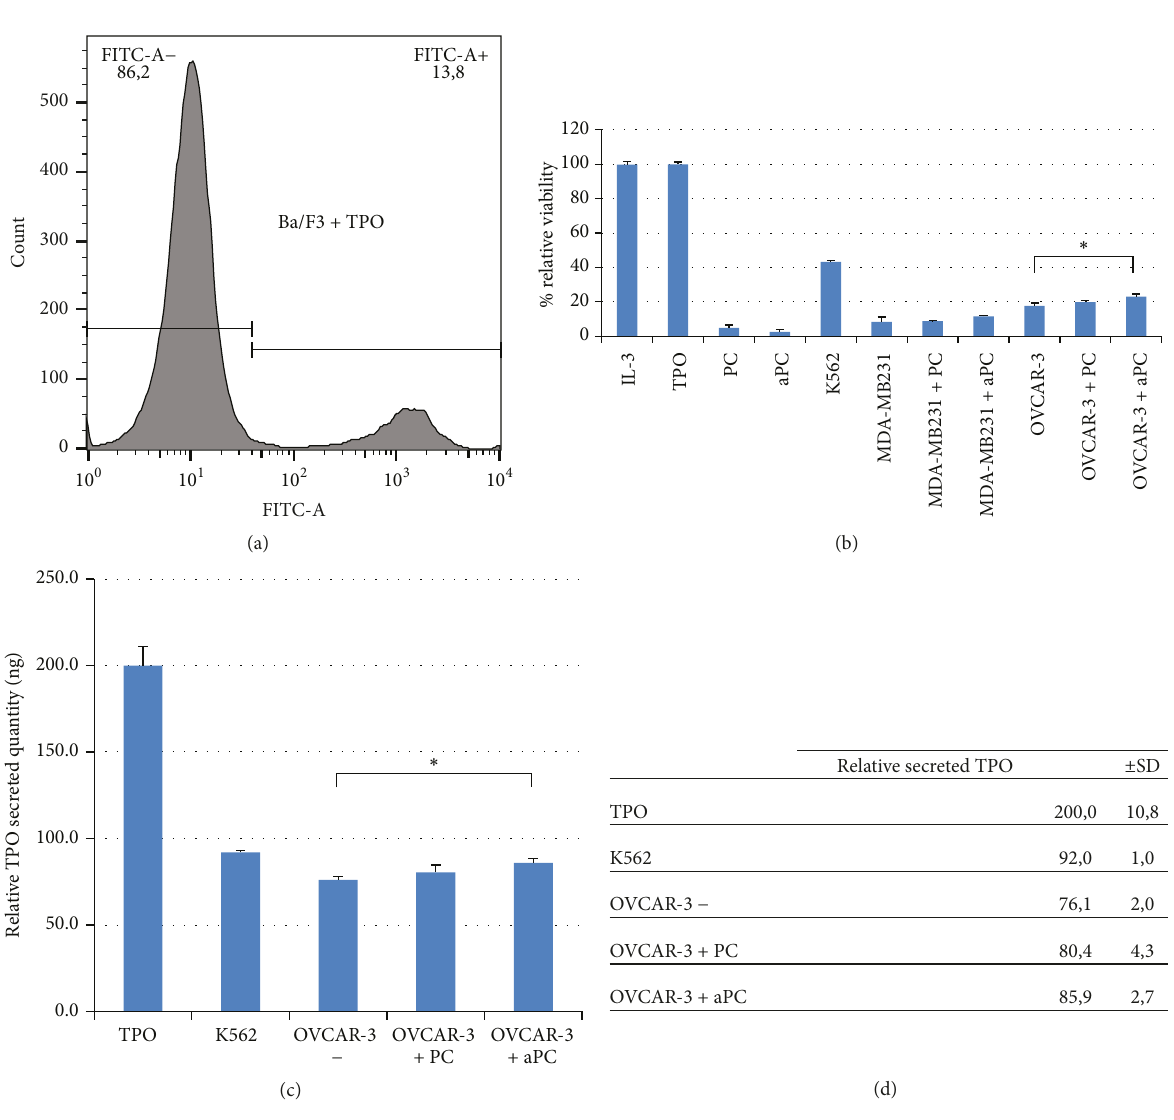
Figure 6: Functionality of TPO: viability study of TPO-dependent Ba/F3 cells. (a) The panel shows the distribution of two populations of Ba/F3 cells cultured in the presence of TPO: a nonlabeled population FITC-Annexin-V (viability) and a labeled population FITC-Annexin-V (apoptosis). (b) The graph shows Ba/F3 viability (not stained by FITC-Annexin-V). (c, d) Relative TPO secreted quantity (ng). ( 𝑃 < 0 , 02 ). Student’s 𝑡 -test ( ∗ 𝑃 < 0 , 05